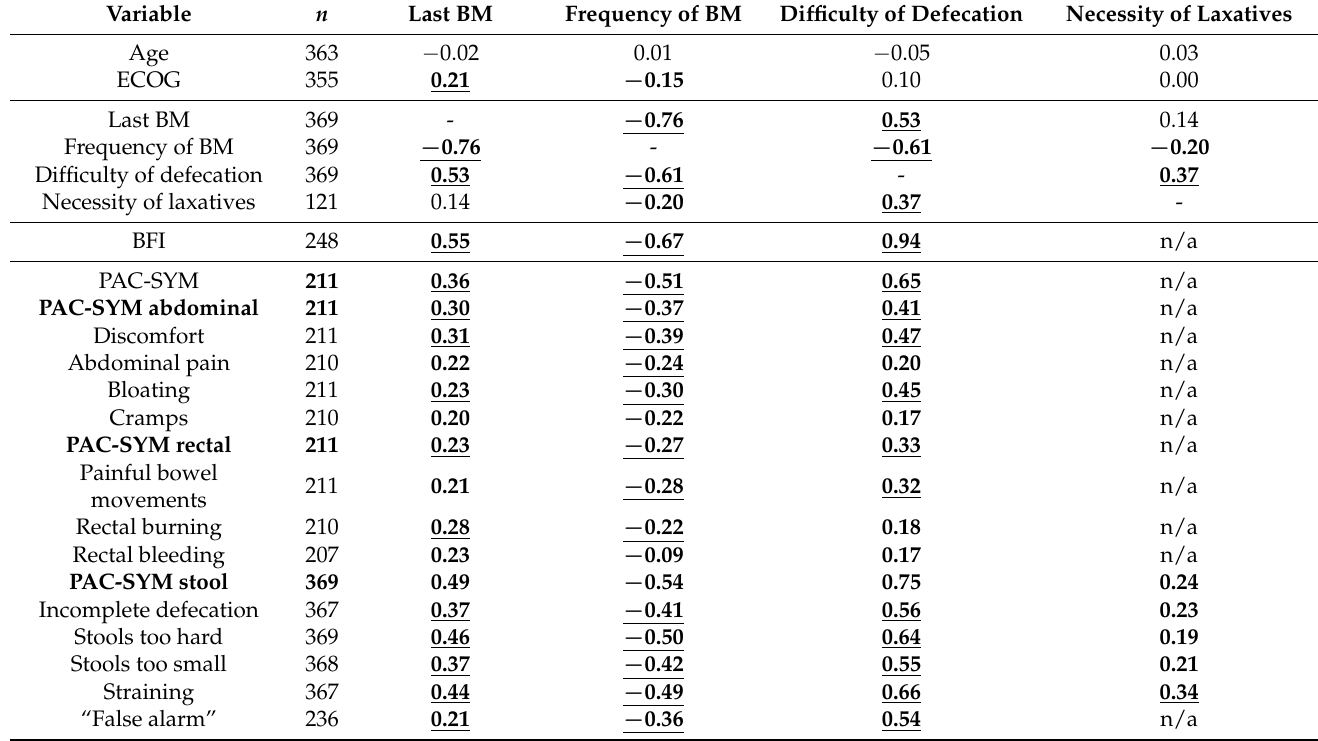
Table 3. Spearman rank-order correlations (bold when p < 0.05; bold underlined when p <